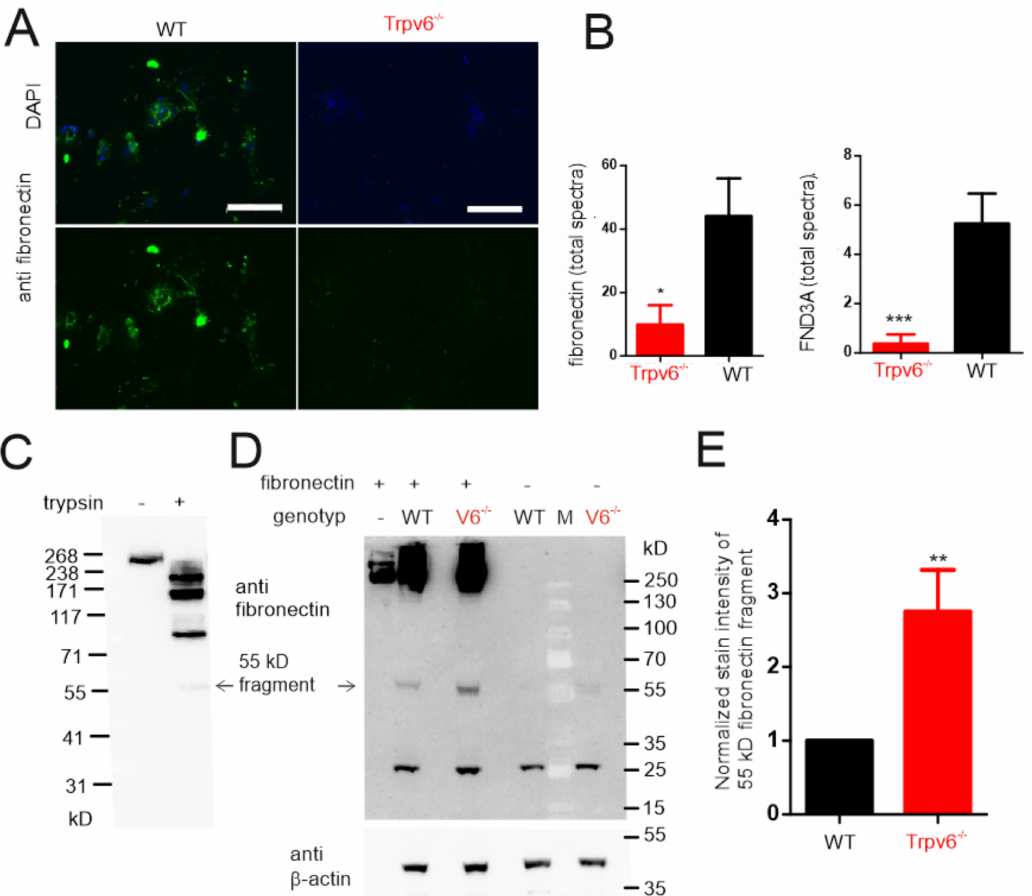
Figure 6. Fibronectin and FND3A are more abundantly expressed in wt trophoblasts ( A ) Detection of fibronectin in trophoblast cells at day 3 of cell culture after isolation from placentae with anti-fibronectin antibody, bar = 100 µ m. ( B ) MS / MS-identified spectra of fibronectin and FND3A protein identified in wild-type and transient receptor potential vanilloid 6 (Trpv6)-deficient trophoblasts ( n = 8 lysates / genotype). The significance di ff erence between groups was calculated using Student’s t -test (* p < 0.05, ** p < 0.01, *** p < 0.001). ( C ) Western blot of tryptic-digested and non-digested fibronectin with a fibronectin antibody. ( D ) Western blot analysis of a protease assay with placenta lysates. Placenta lysates from wt and Trpv6 - / - were incubated with fibronectin for 1 h and fibronectin fragments were detected with anti-fibronectin antibody. A beta-actin antibody was used as loading control. ( E ) Bar graph shows the normalized intensity of the proteolytic fibronectin fragment detected in wt and Trpv6 - / - placenta lysates by Western blot analysis in n = 3 experiments. Results are shown as mean +